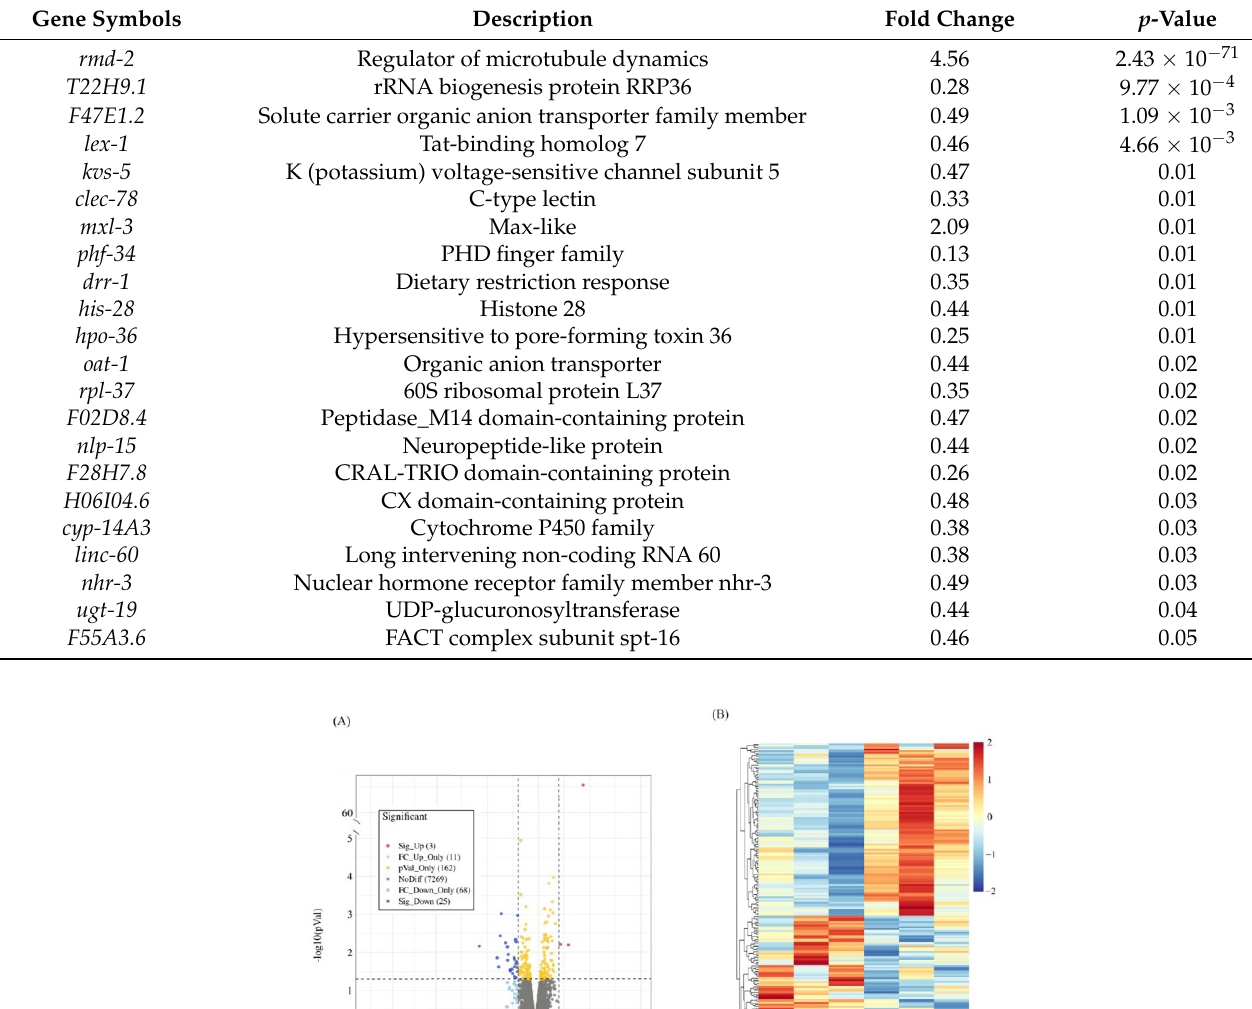
Table 2. The DEGs in C. elegans treated with astaxanthin.